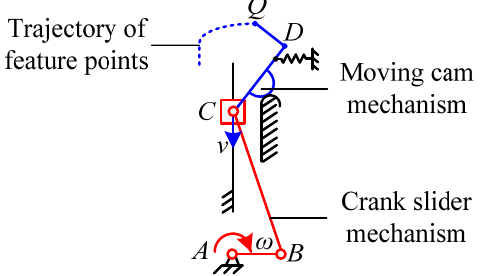
Figure 14. Schematic diagram of the capture and lock mechanism.